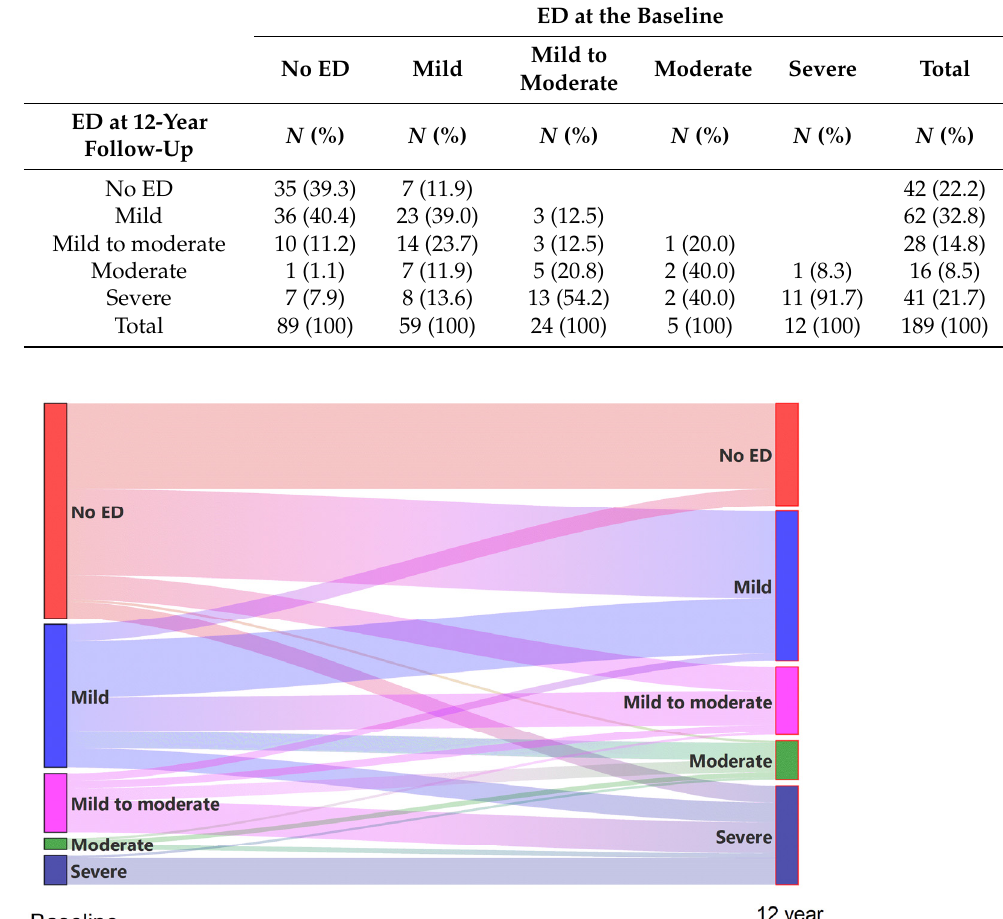
Table 4. Factors which were important in terms of the progression and regression of ED.